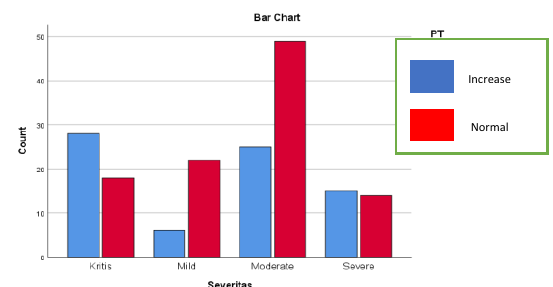
Figure 3. Diagram of the Relationship between Elevated ALT and